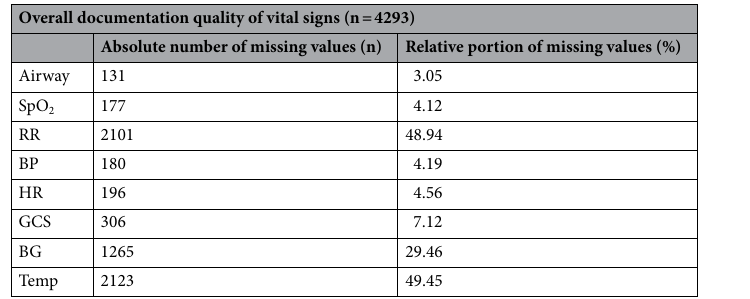
Table 3. Overall documentation quality of vital signs. Missing values are presented in absolute and relative numbers. SpO